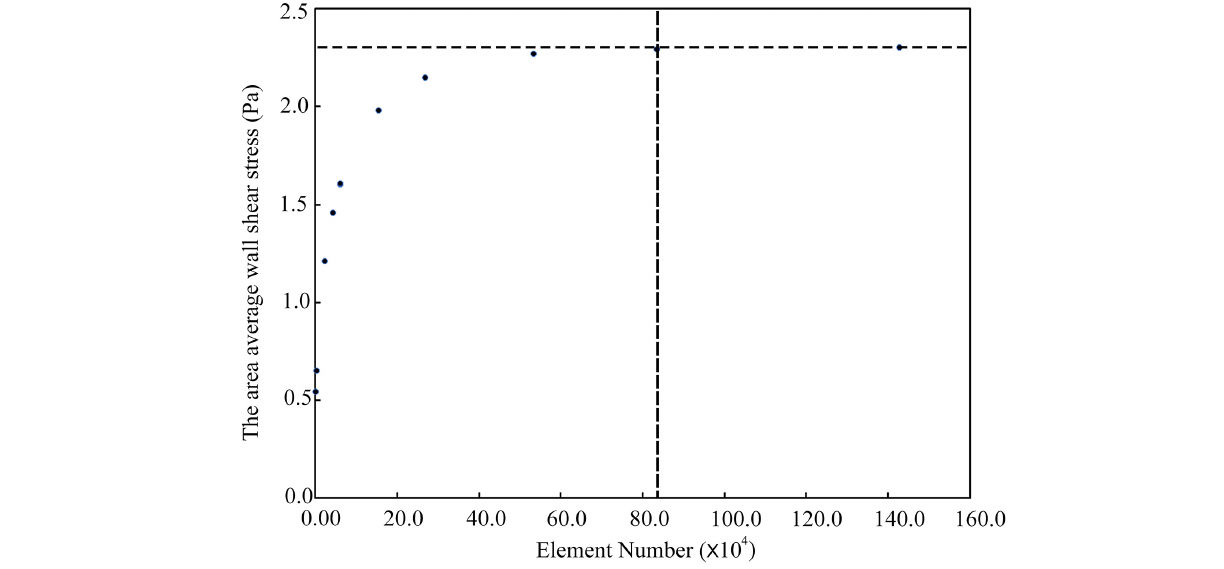
FIGURE 3 | The mesh independence test.